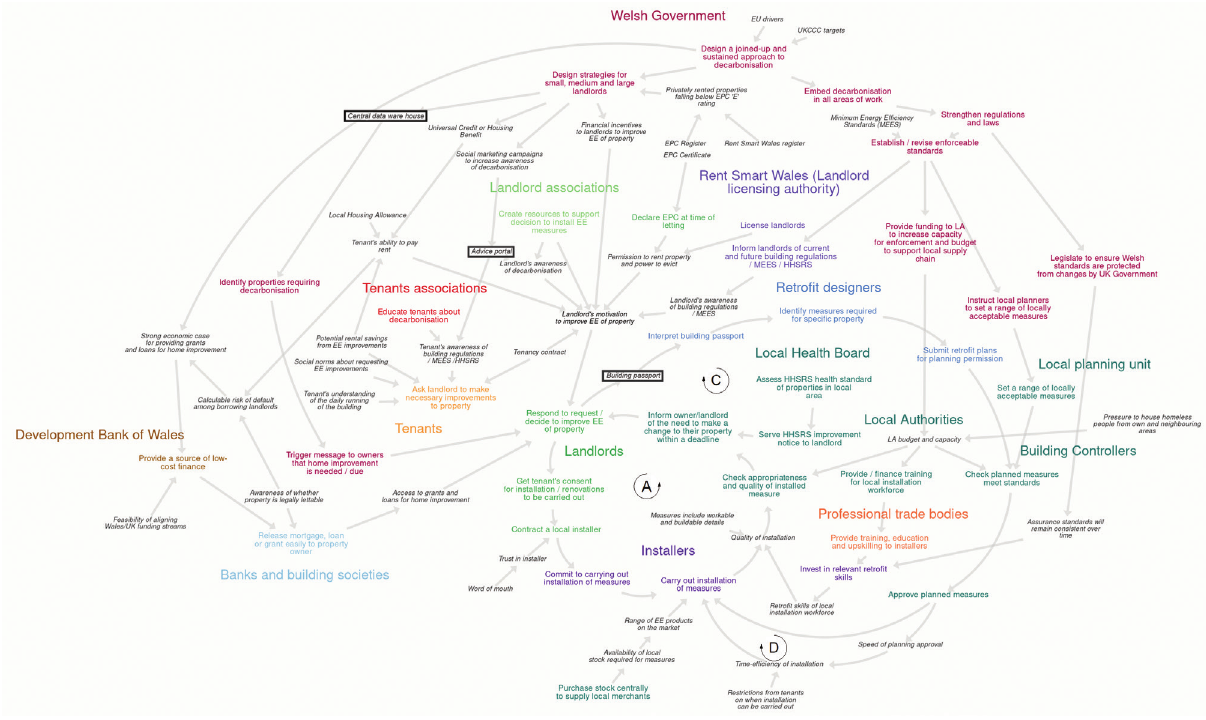
Behavioural systems map for private landlords. Note. This figure shows a qualitative BSM for the system of decarbonising homes owned by private landlords. The map represents the system ‘as it could be’, meaning that it reflects the reality of the current system, but it also includes behaviours and influences that could be put in place to support retrofit at scale. Actors are shown in large bold text. Behaviours are shown in medium bold text. Influences on behaviour are shown in small italic text. Colour coding is used to show which actors perform which behaviours. Arrows are used to show positive causal links identified among behaviours and influences on behaviour. Black text boxes are used to show potential new services or resources identified to support decarbonisation. Abbreviations: EE, energy efficiency/ energy efficient; EPC, energy performance certificate, HHSRS, housing health and safety rating system; LA, local authority; MEES, minimum energy efficiency